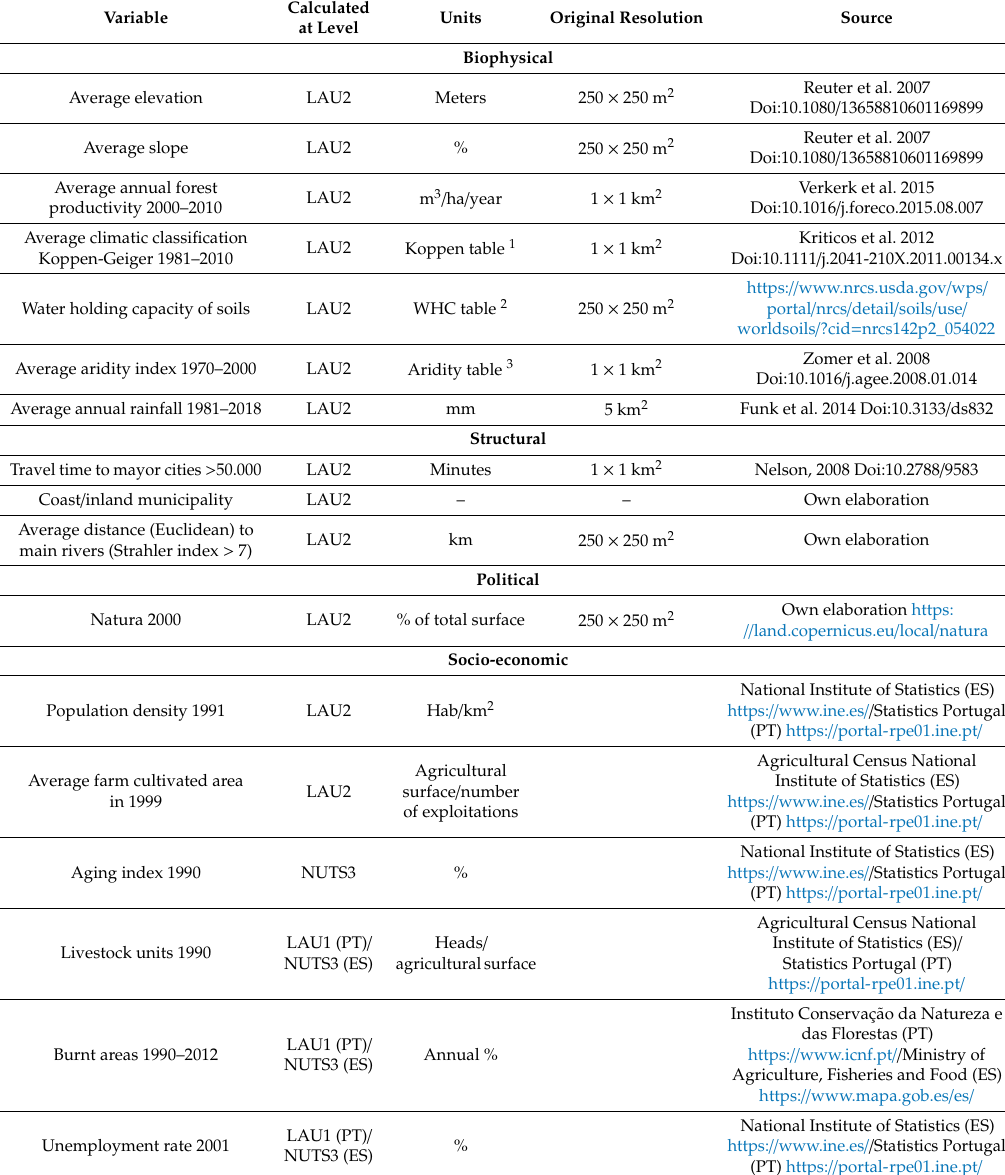
Table 1. Variables introduced in the